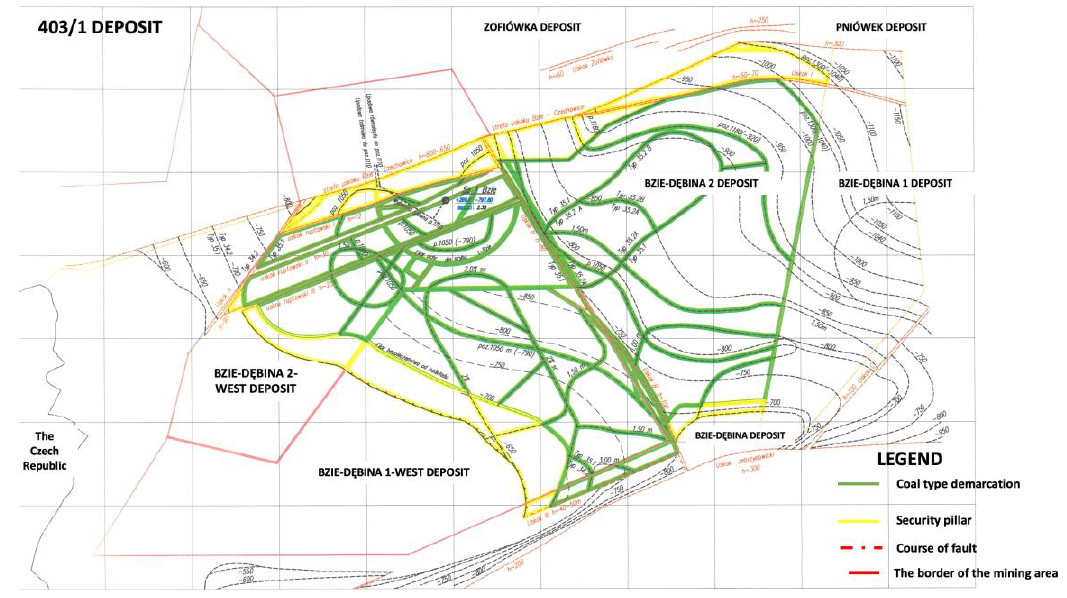
Figure 3. Map of the 403/1 coal seam. Table 2. Compressive strength of coal and surrounding rocks of 403/1 coal seam.